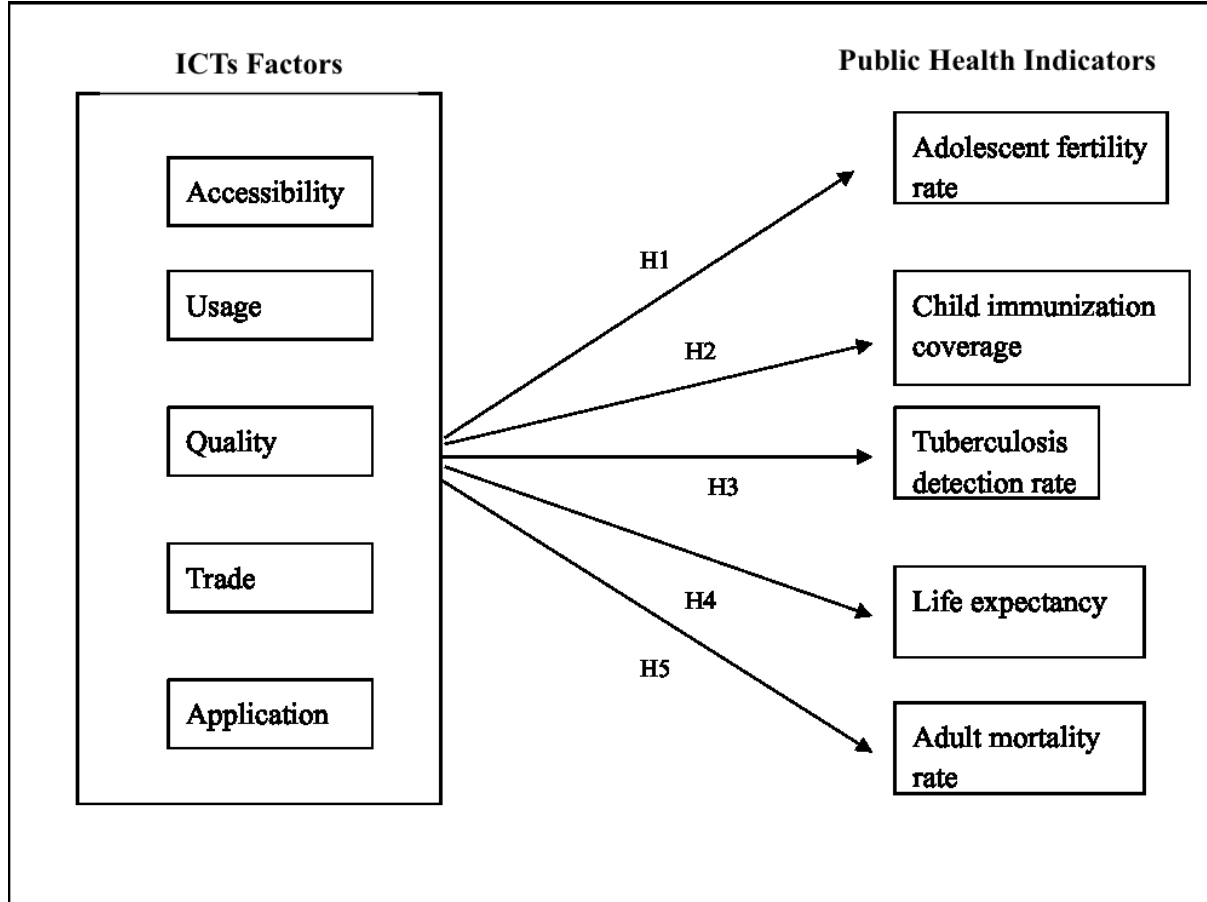
Figure 1. Conceptual